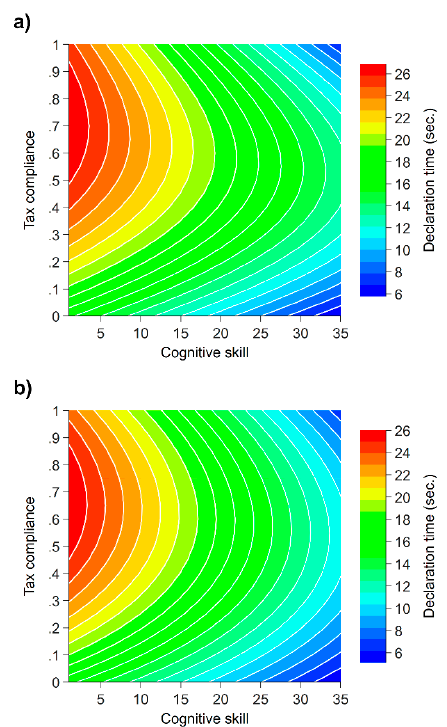
Figure 5. Predicted declaration time as a function of tax compliance and cognitive skill. ( a ) Predicted values obtained from Ordinary Linear Regression (OLS) with individual-declaration time as dependent variable and full interaction between tax compliance level of individual-decisions, tax compliance level squared, and cognitive skill as predictors ( N = 2880); and, ( b ) Predicted values obtained from OLS using individual-average decision time as dependent variable and full interaction between individual-average tax compliance level, tax compliance level squared, and cognitive skill as predictors ( N = 180).